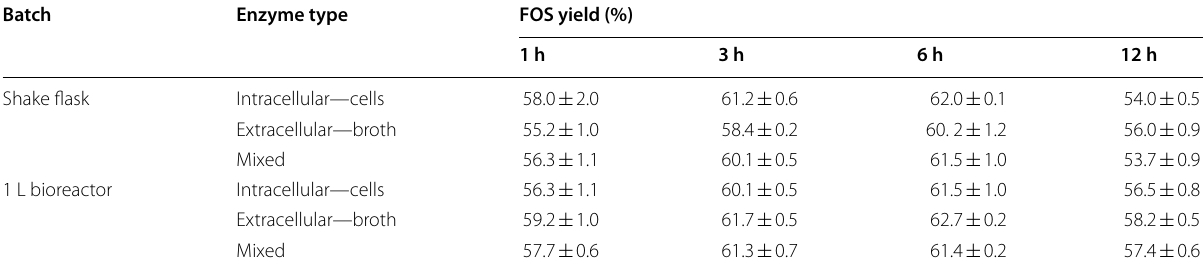
Table 4 FOS yields using intracellular, extracellular and mixed enzymes from shake flasks and 1 L reactor